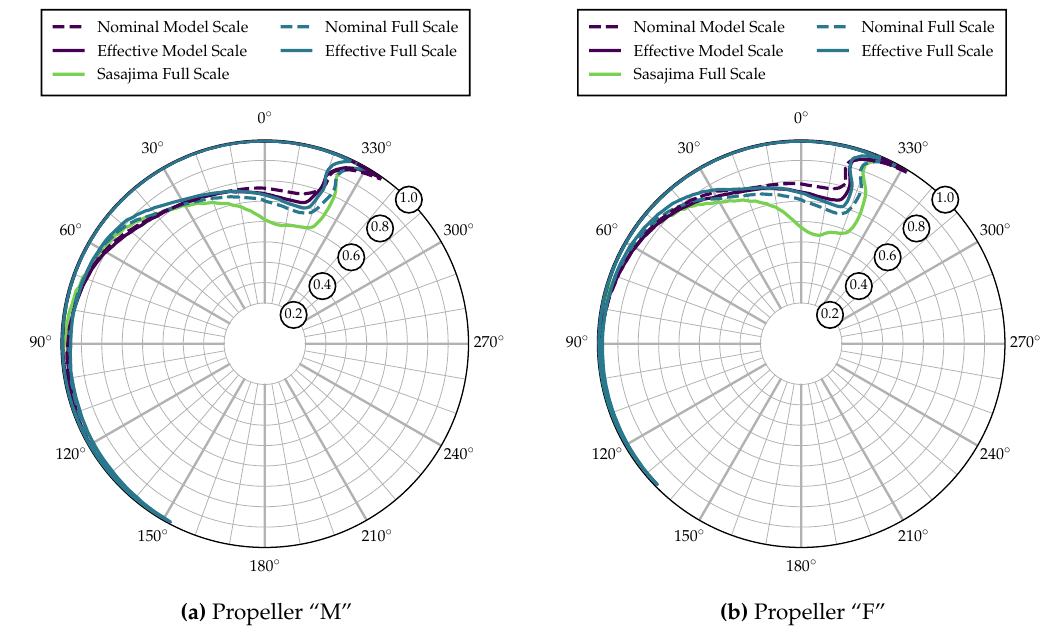
Figure 3. Radial cavitation